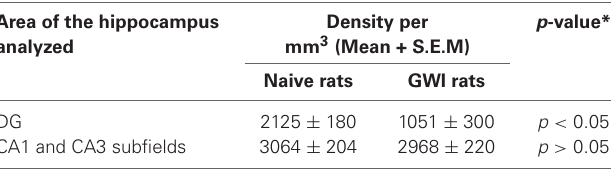
Table 1 | Density of parvalbumin (PV) positive interneurons in the hippocampus . Area of the hippocampus Density